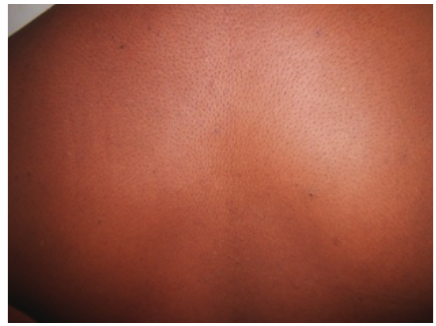
Figure 4: Complete recovery of the patient after 15